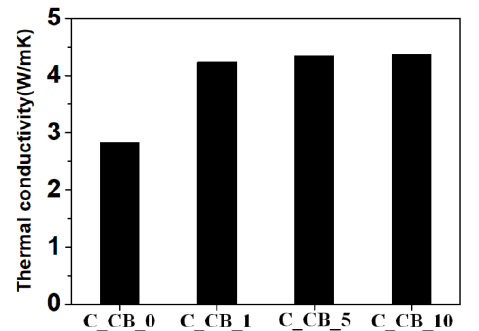
Figure 9. The thermal conductivity of carbon blocks according to the added CB amount.